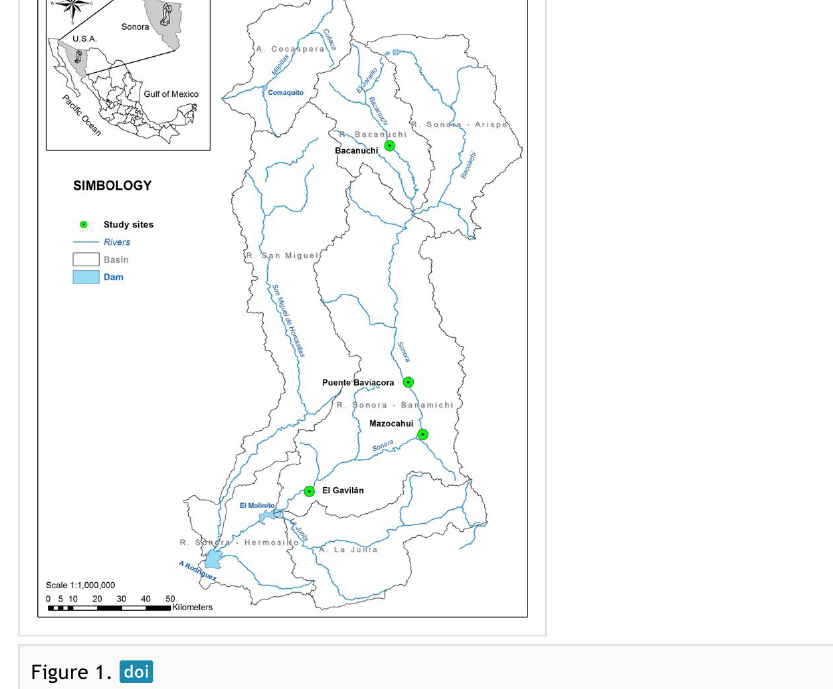
Materials examined